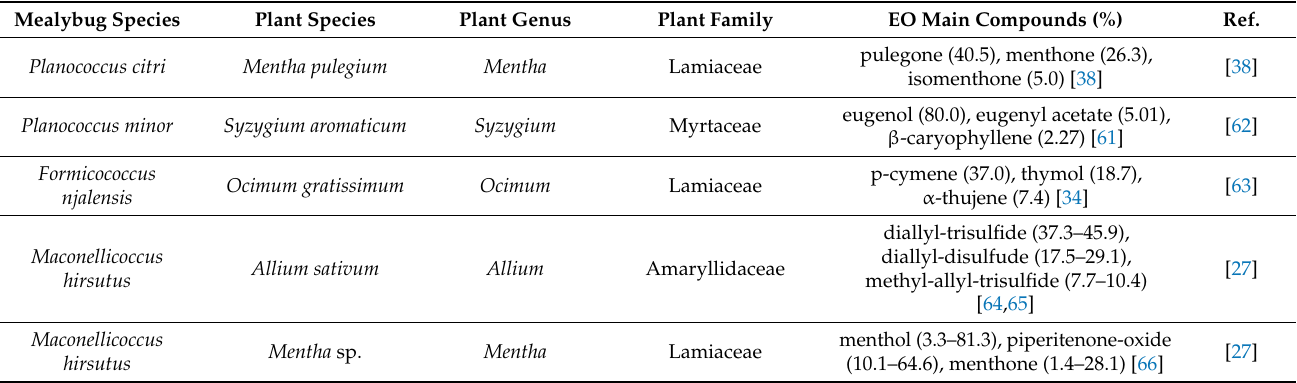
Table 1. Plant EOs evaluated for their toxicity against mealybugs from the Pseudococcidae